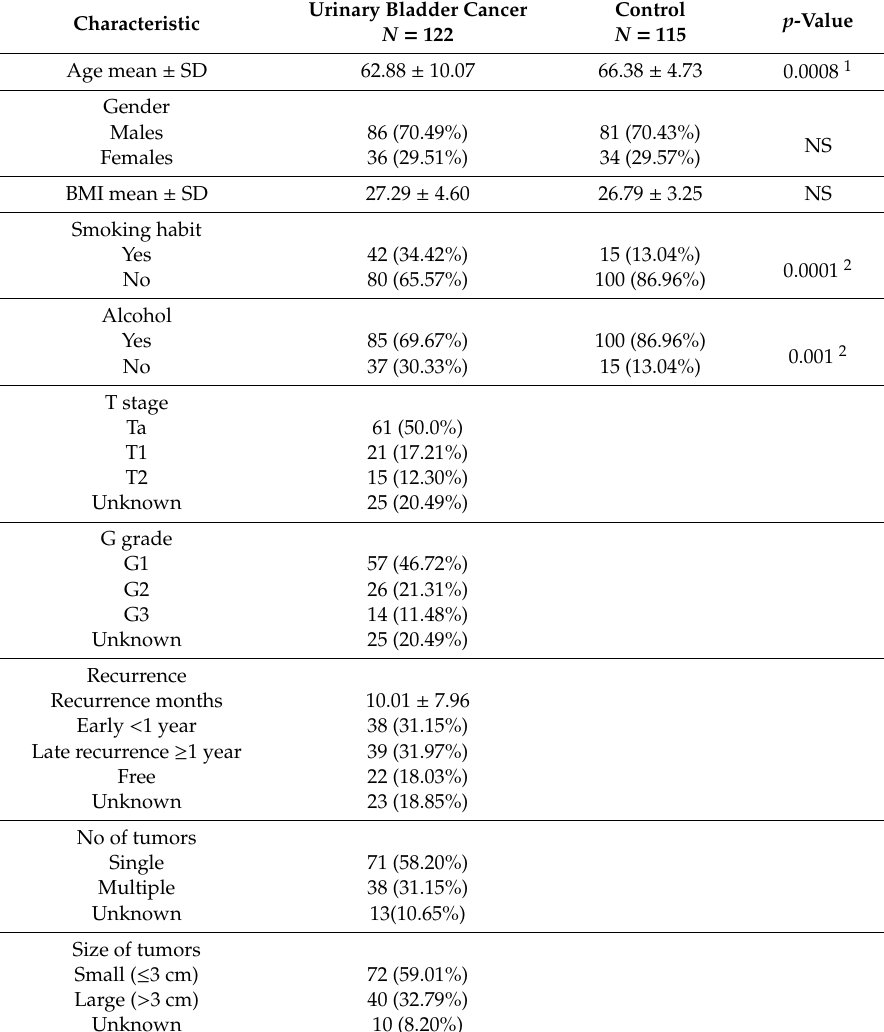
Table 1. Demographic and histopathological